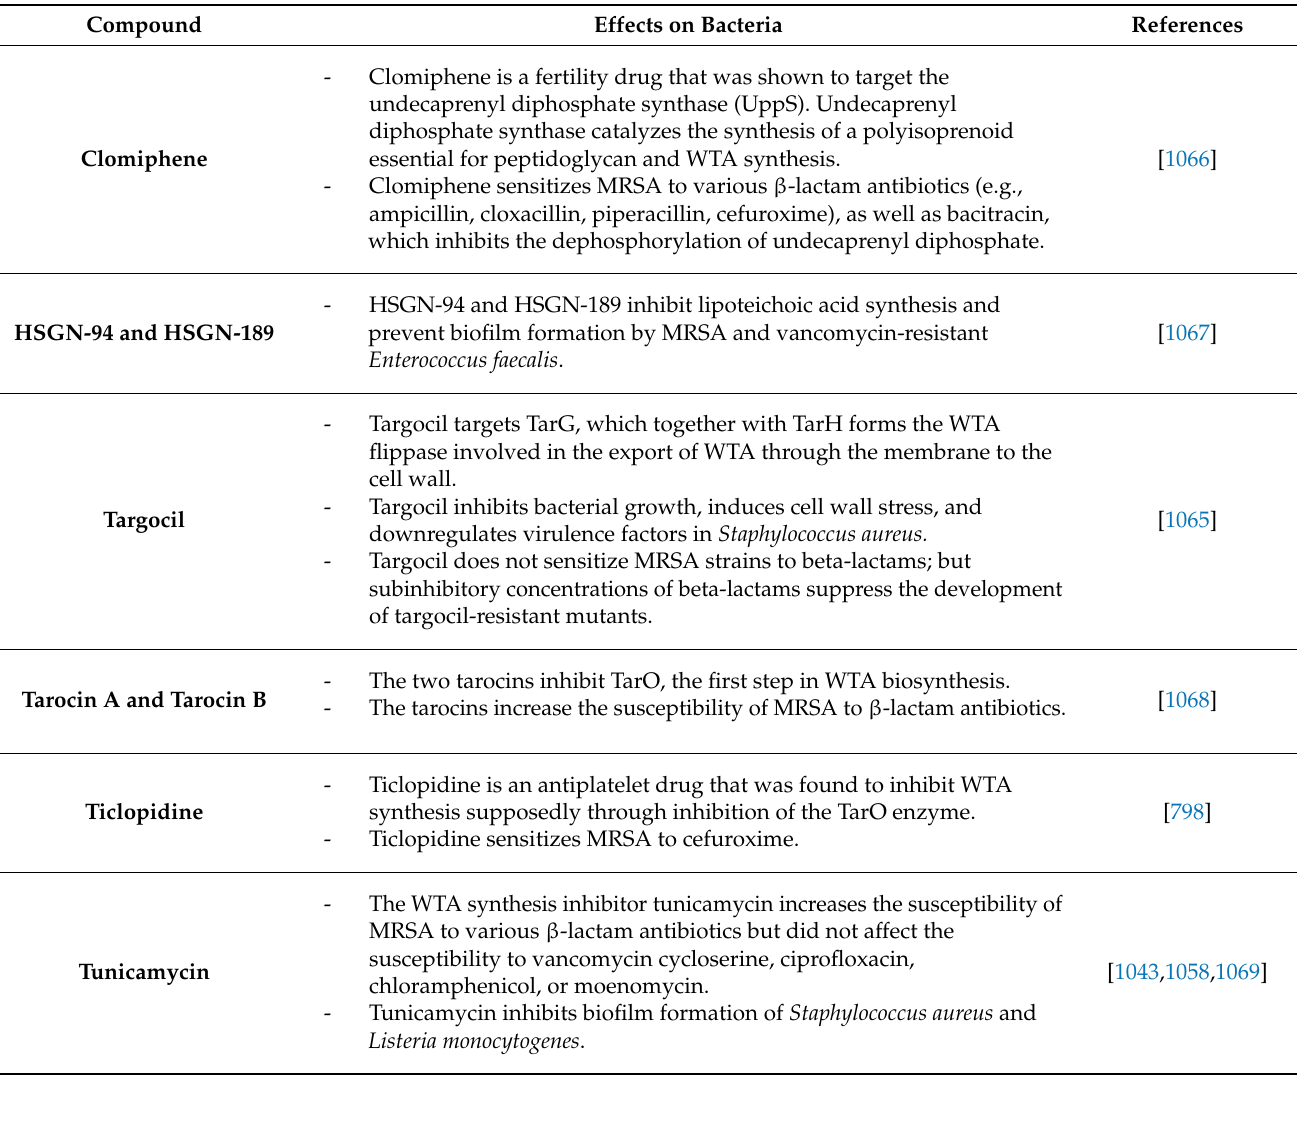
Table 7. Examples of compounds targeting wall teichoic acid (WTA) synthesis. Effects on